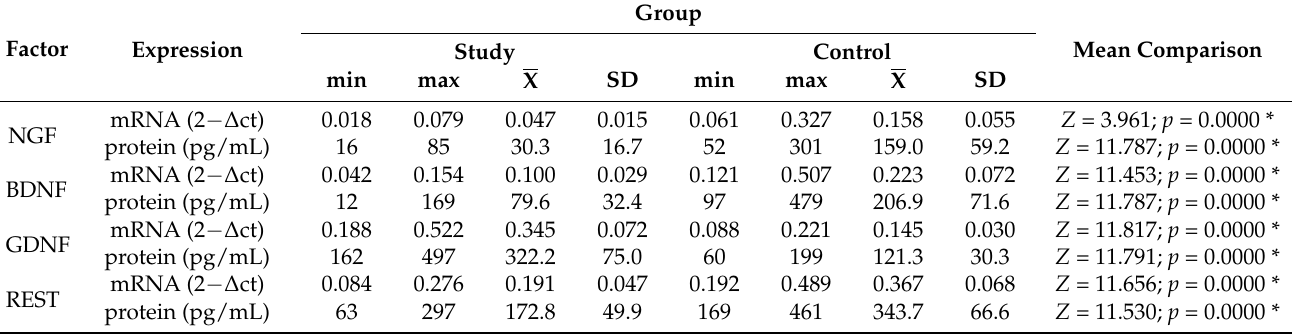
Table 2. Comparison of neurogenesis regulating genes expression in both studied groups.